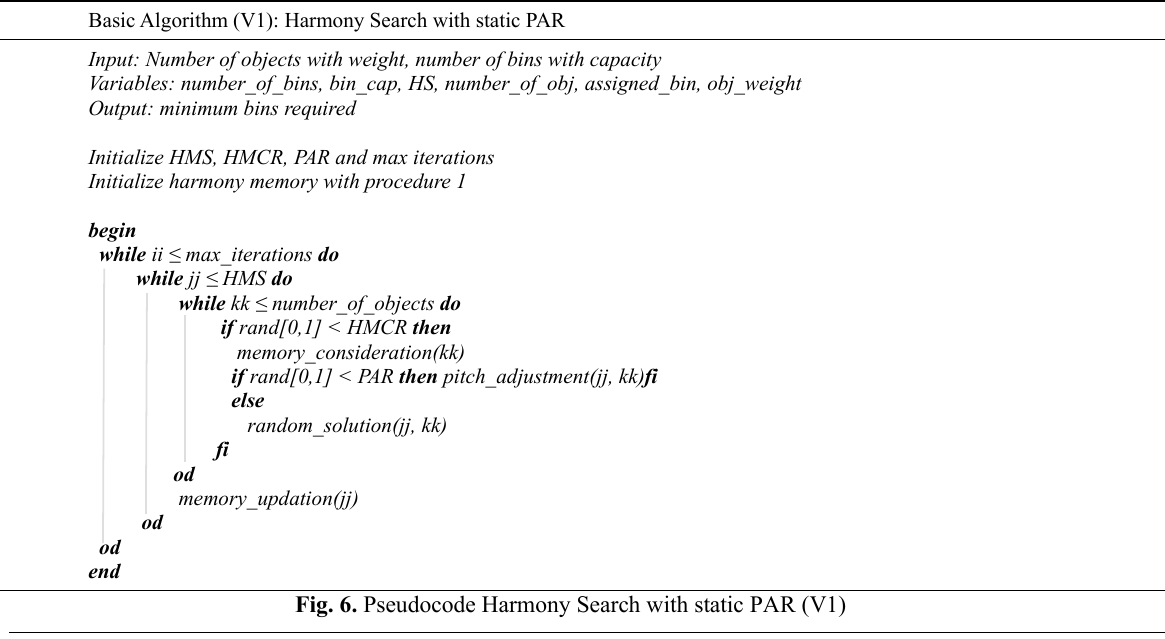
Fig. 6. Pseudocode Harmony Search with static PAR (V1)